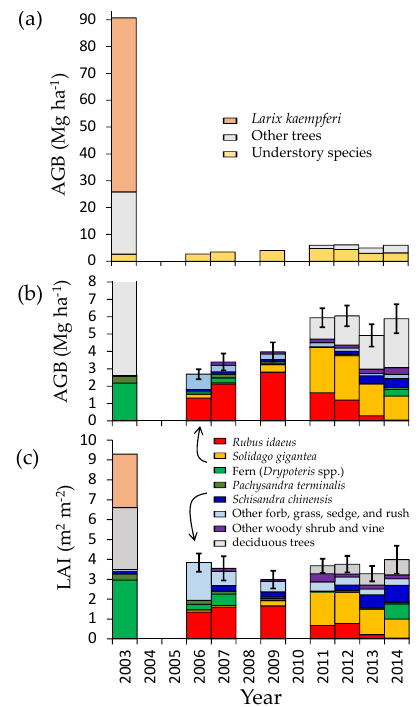
Figure 1. Annual changes in ( a ) aboveground biomass (AGB); ( b ) AGB classified by species; and ( c ) leaf area index (LAI) at peak-growth period classified by species before and after disturbance. Error bars in ( b ) and ( c ) represent 1 standard error of total understory AGB (solid, n = 10), total AGB (grey), or total LAI (grey). Data before disturbance were obtained from earlier studies [2,36–38]. Standard errors in total AGB and LAI were calculated by the law of error propagation.